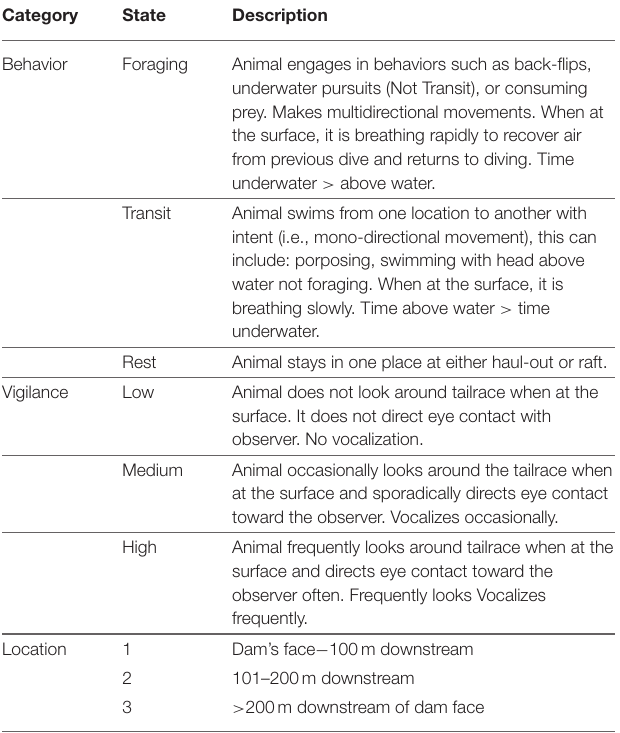
TABLE 1 | Ethogram of Steller sea lion behavior used to categorize behavioral response to non-lethal hazing at Bonneville Dam. Category State Description